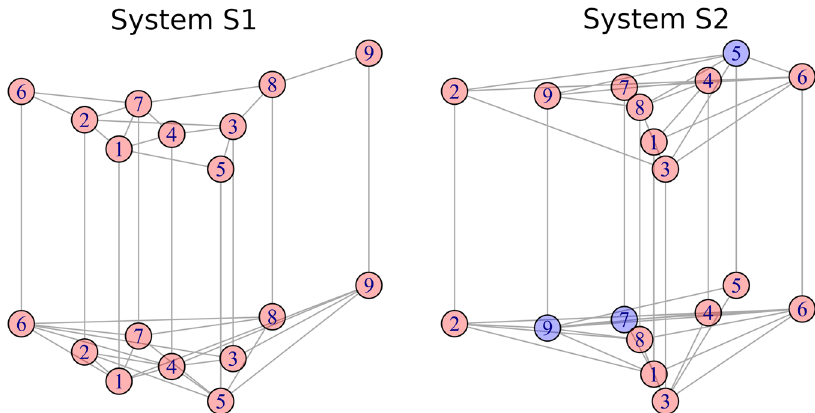
and, for different interlayer strengths (logarithmic scale) the multilayer diffusion capacity M ð G 1 Þ and M ð G 2 Þ ( B ). Evolution of the Multilayer diffusion Capacity for small interlayer strength values ( C